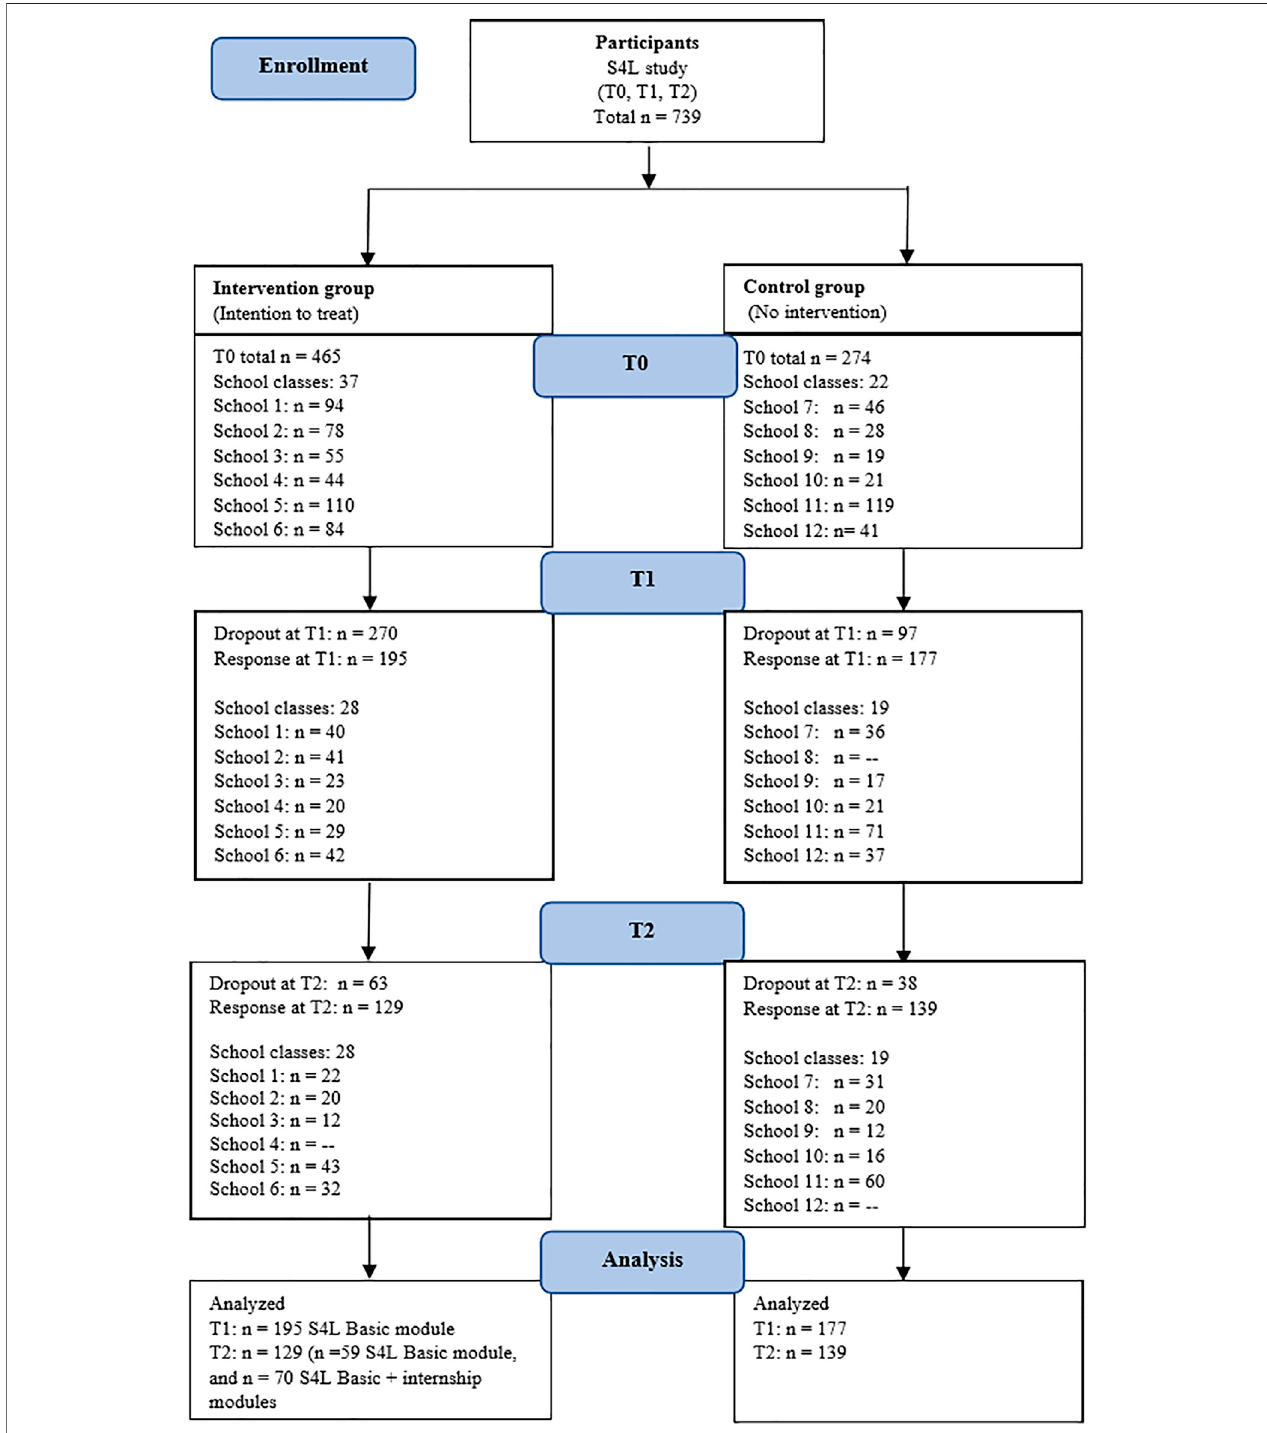
FIGURE 1 | Flow chart of Participants, Sample size, Dropout students, School Classes and Schools.